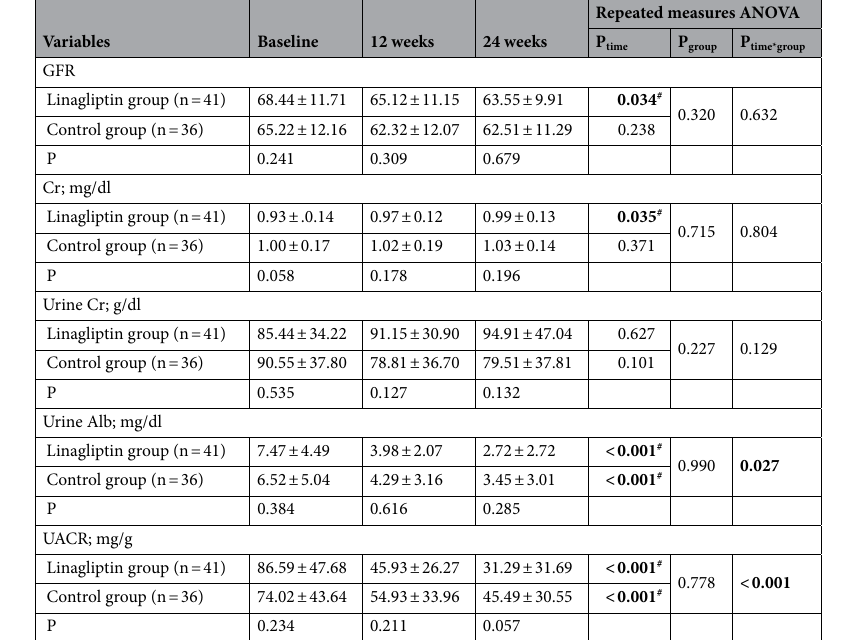
Table 4. Parameters related to renal function and microalbuminuria in two groups. Cr creatinine, GFR glomerular filtration rate test, UrineAlb urine albumin, UrineCr urine creatinine, UACR urine albumin- creatinine ratio. P is obtained from an independent samples t -test conducted for comparing the mean of the variables between the two groups at each follow-up time point. P group indicates the overall difference between the two groups over the follow-up period. P time demonstrates the changes in the mean of the variables in the intervention and control groups over the follow-up period. P time*group indicates the interaction between the time and intervention. P group , P time , and P time*group are obtained from repeated measures ANOVA. Significant values are given in bold. # Statistically significant